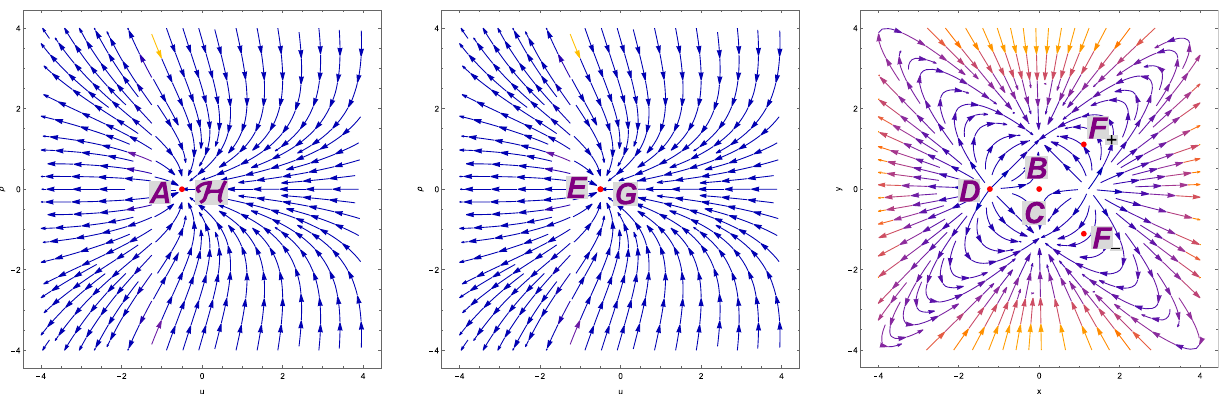
Fig. 1 Phase portrait for the dynamical system of Model-I, (i) left panel( x = 0, y = 0, z = 1 . 5, λ = 0 . 001); (ii) middle panel ( x = 0, y = 0, λ = 0 . 001) (iii) right panel ( ρ = 0, z = 1 . 5, λ = 0 .